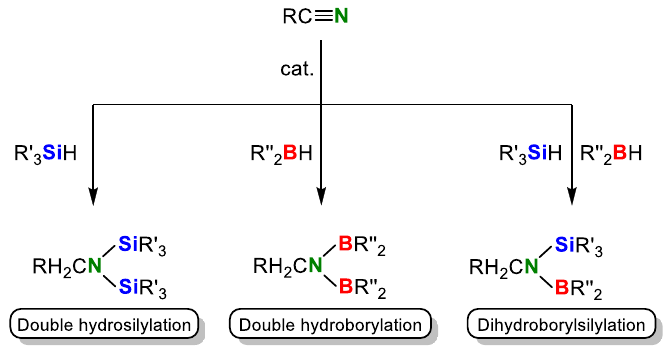
Scheme 1. Double hydrosilylation, double hydroborylation, and dihydroborylsilylation of organonitriles. Figure 1. Metal catalysts for double hydrosilylation and double hydroborylation of organonitriles.